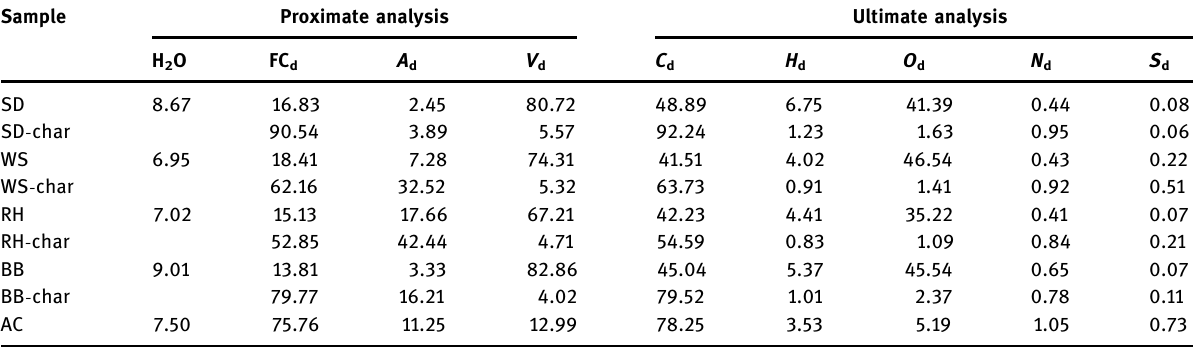
Sample Proximate analysis Ultimate